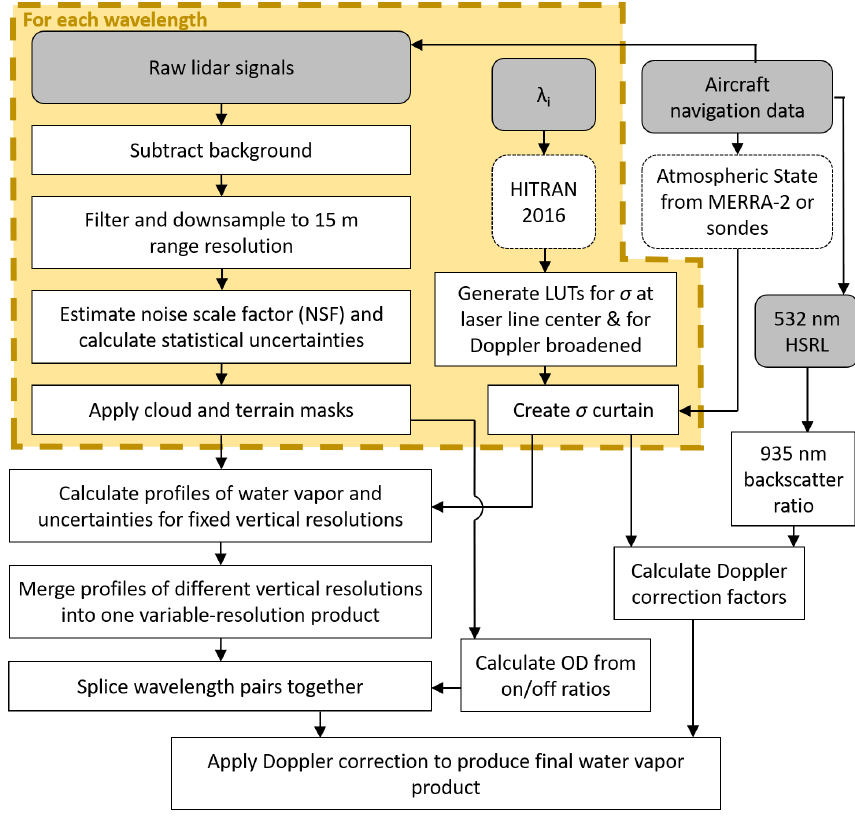
Figure 2. Flowchart of the HALO WV retrieval steps. Gray boxes are data or user